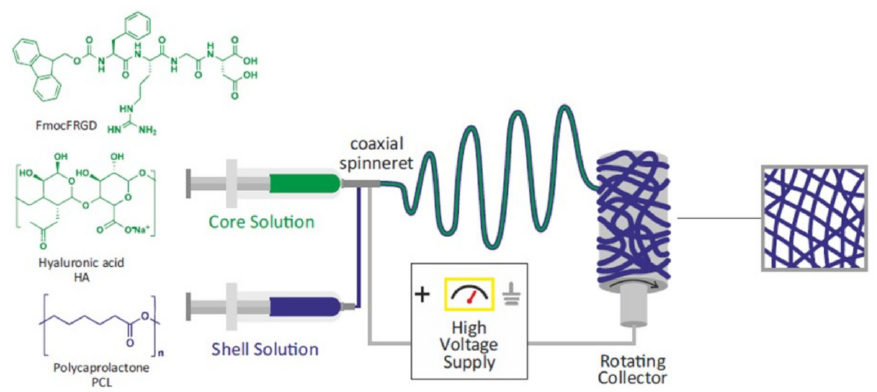
Figure 1. Schematic illustration of the electrospinning system used to fabricate the nanofibrous scaffolds, and the molecular structures of the different components